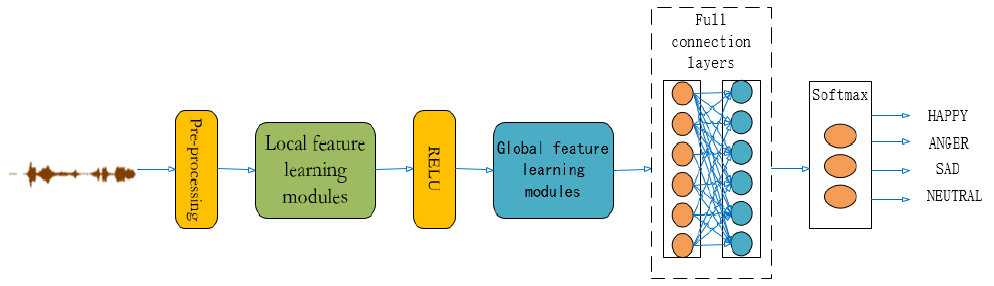
Figure 1. The overall model architecture proposed in this